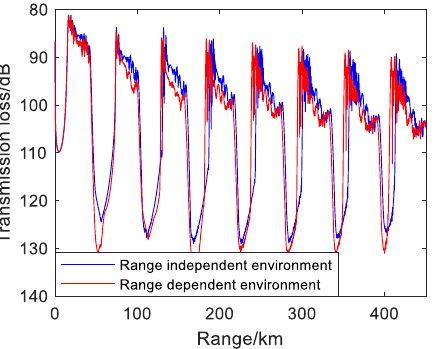
Figure 6. Transmission losses in range-independent and range-dependent environments for ellip- soidal Gaussian eddy case.